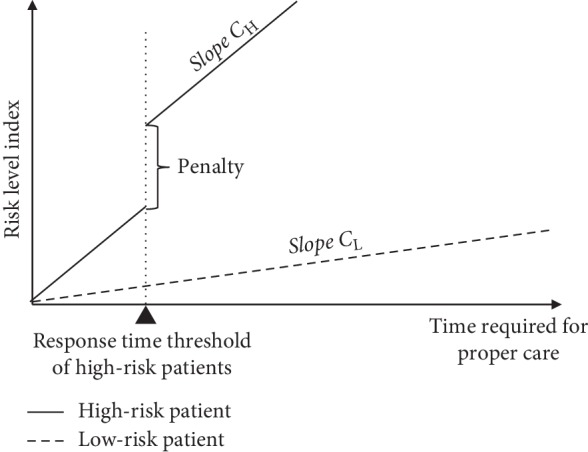
Risk level index function.